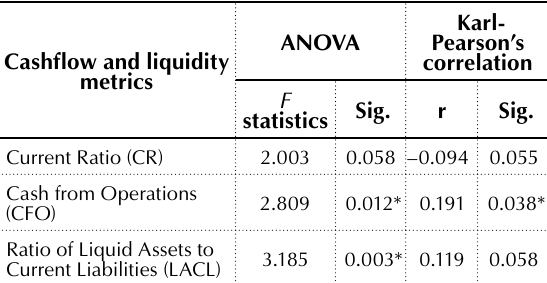
Table 5. Results of ANOVA and correlation analysis of the relationship between cash flows and liquidity and dividend pay-out ratio